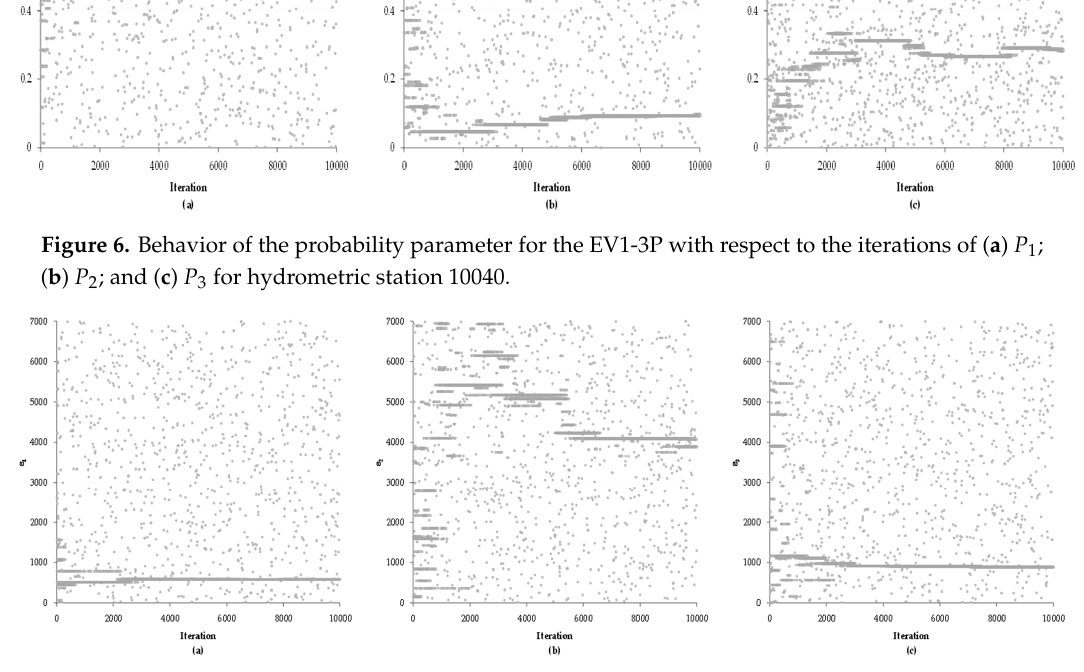
Figure 7. Behavior of the location parameters for the EV1-3P with respect to the iterations of ( a ) ε 1 ; ( b ) ε 2 ; and ( c ) ε 3 for hydrometric station 10040.